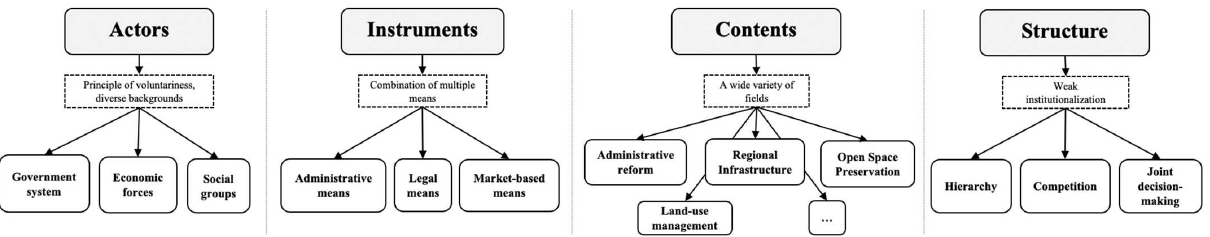
Figure 1. The Actor–Instrument–Content–Structure (AICS) framework. Source: the authors.